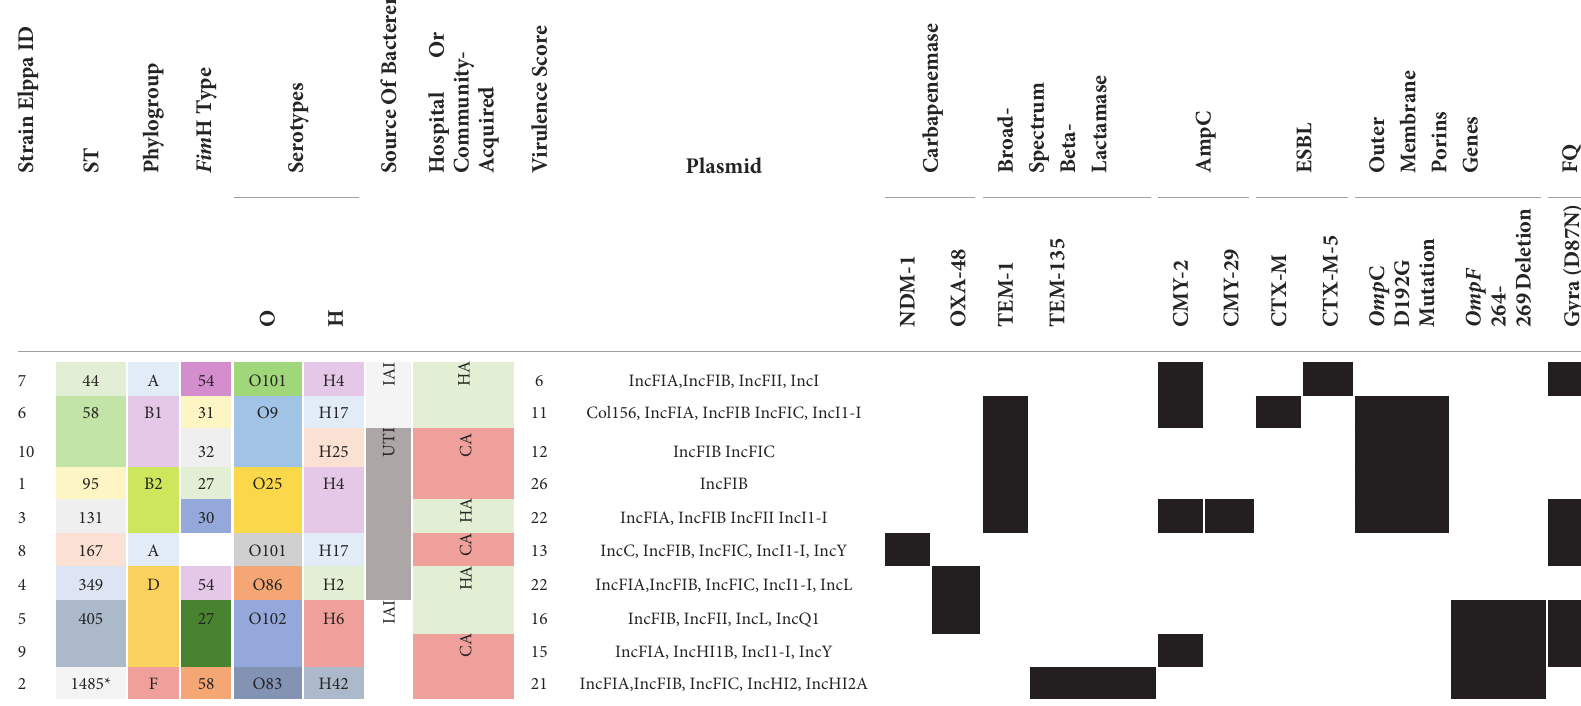
TABLE 2 Genetic diversity, source of bacteremia, and antibiotic-resistant mechanisms identified in the E. coli